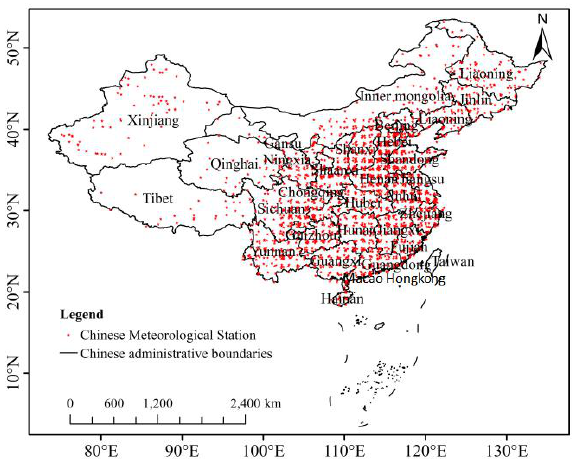
Figure 1 Distribution map of the meteorological stations in China